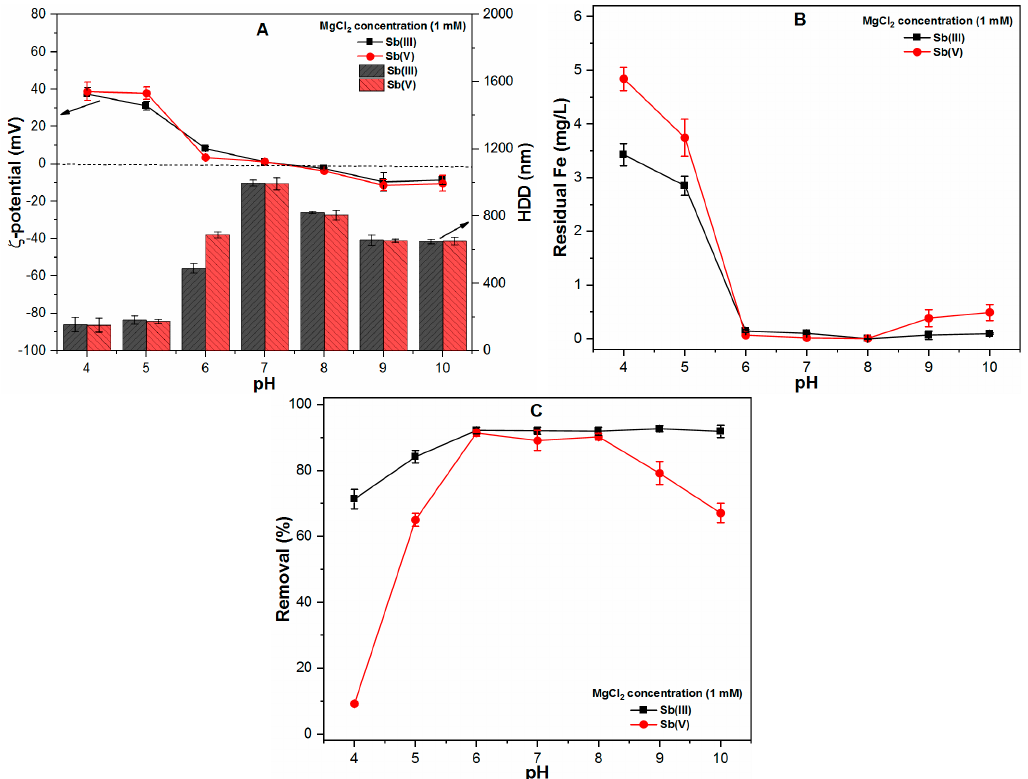
Figure 4. At various pH ranges (4–10), FC dose (0.1 mM), temperature (25 ± 1 °C), MgCl 2 concentration (1 mM) and Sb(III, V) concentration (1 mg / L) showing ( A ) ζ -potential (mV) and HDD of precipitates (nm); ( B ) Residual Fe (mg/L) and; ( C ) Removal (%) of both Sb species.